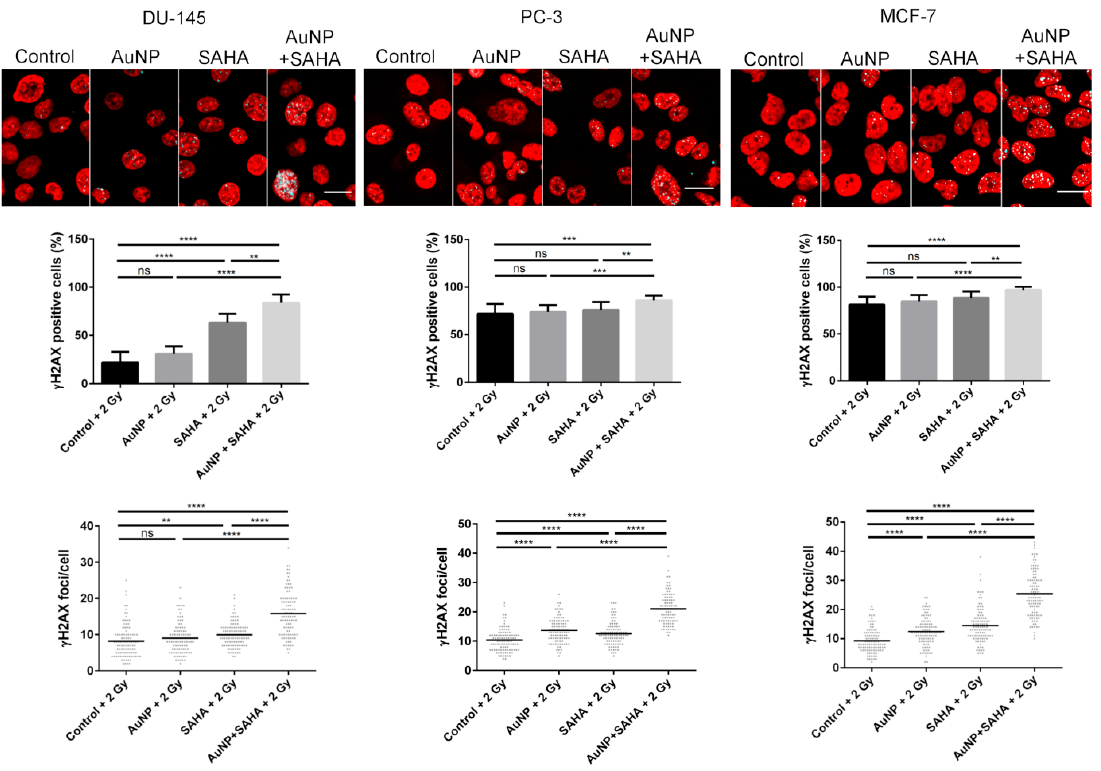
Figure 7. AuNP and SAHA combination induces significant DNA damage after 2 Gy irradiation. Significantly more γ H2AX-positive cells were counted in the AuNP + SAHA-treated samples compared to the control and to the individual treatments after 2 Gy irradiation in all the tested cell lines. (** p value < 0.005 *** p value < 0.001; **** p value < 0.0001; Unpaired t-test) . The number of γ H2AX foci was significantly increased after AuNP + SAHA treatments than in the untreated and in AuNP- or SAHA-treated γ H2AX-positive cells. Scale bar represents 20 µ m. (** p value = 0.0019; ****